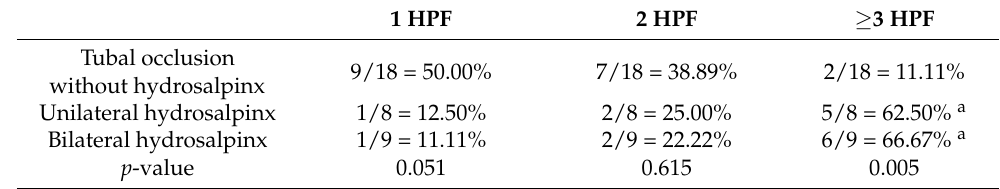
Table 4. Correlation of hydrosalpinx and CD138-positive HPF counts.